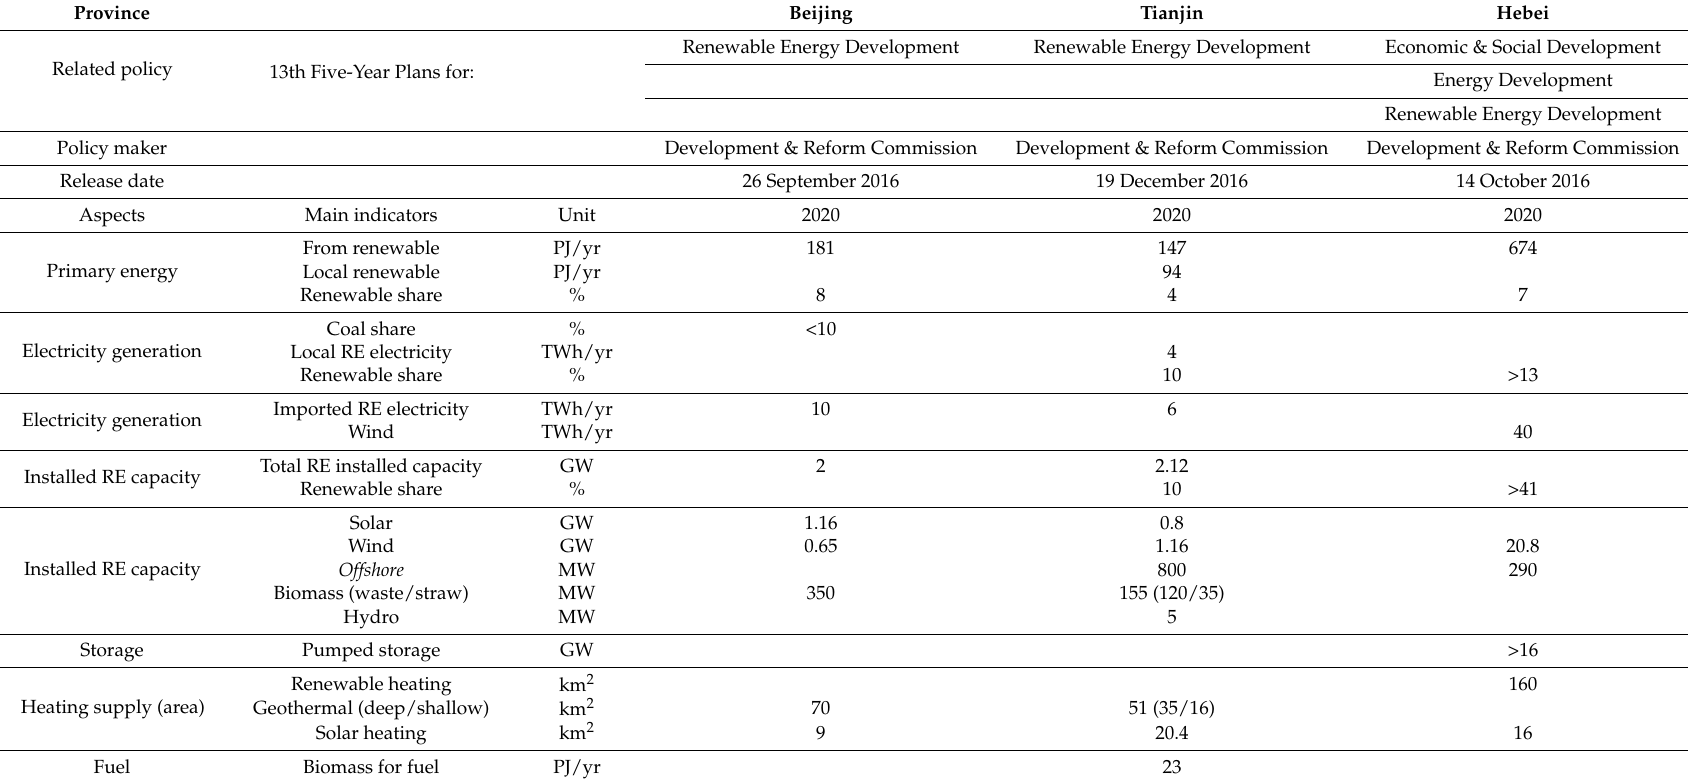
Table 4. Energy transition–related targets in Beijing, Tianjin, and Hebei